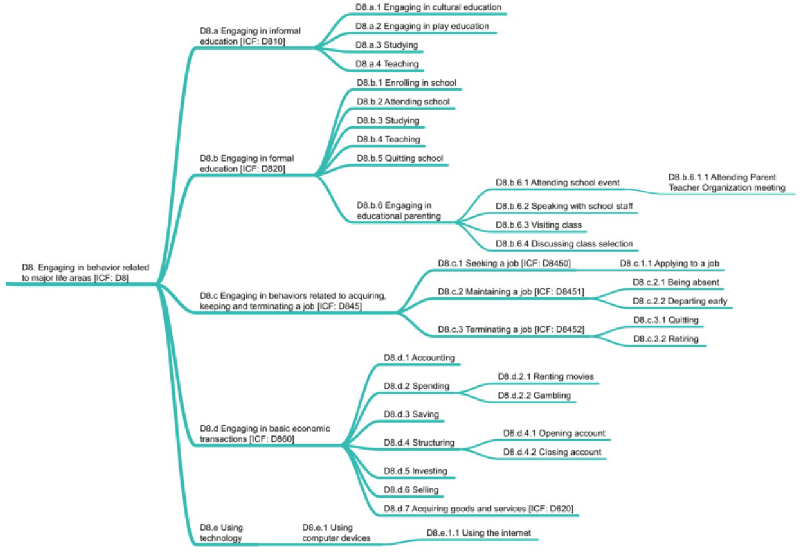
Fig 10. D8 domain on engaging in behavior related to major life